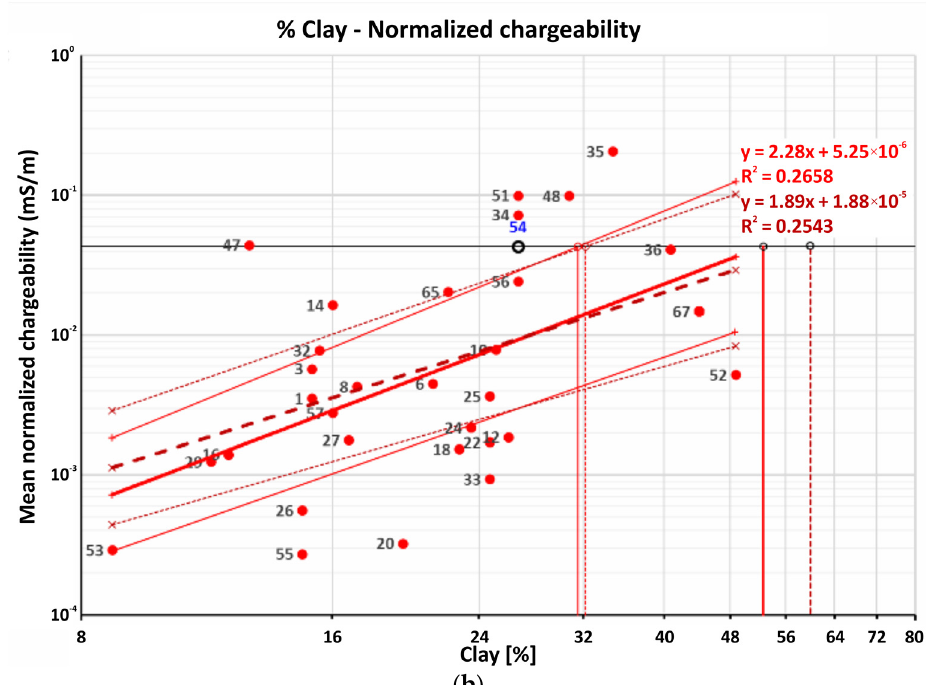
Figure 6. Clay (%) versus Mn (mS/m) log–log diagrams considering the data from 33 sites, surveyed during the dry period. Red solid and dark red dashed slanted lines correspond to the OLS and WLS linear regression, respectively. ( a ) The evaluation of the clay content (vertical solid and dashed lines) from the Mn value for site #19 (black circle); ( b ) the evaluation of the clay content (vertical solid and dashed lines) from the Mn value for site #54 (black circle).